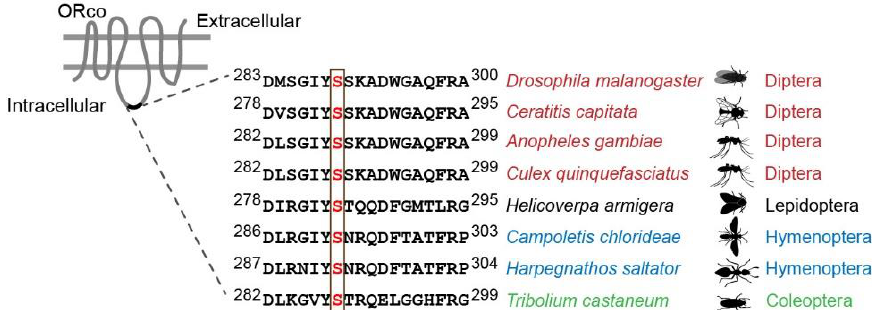
Figure 1. Conservation of the S289 phosphorylation site of Orco across different insect species. The amino acid sequences of Orco were downloaded from the National Center for Biotechnology Information (NCBI): flies D. melanogaster (NP_524235.2) and Ceratitis capitata (NP_001266301.1); mosquitoes Anopheles gambiae (XP_041762121.1) and Culex quinquefasciatus (ABB29301.1); moth Helicoverpa armigera (ADQ13177.1); parasitoid Campoletis chlorideae (AKO69815.1); ant: Harpegnathos saltator (XP_011139767.1); beetle Tribolium castaneum (CAM84014.1).